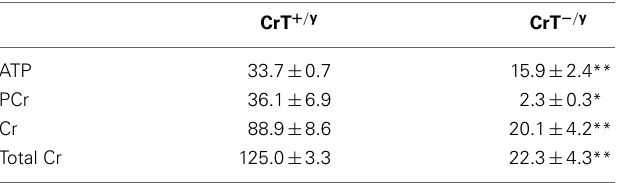
Table 2 | Gastrocnemius metabolite content in CrT + / y and CrT − / y